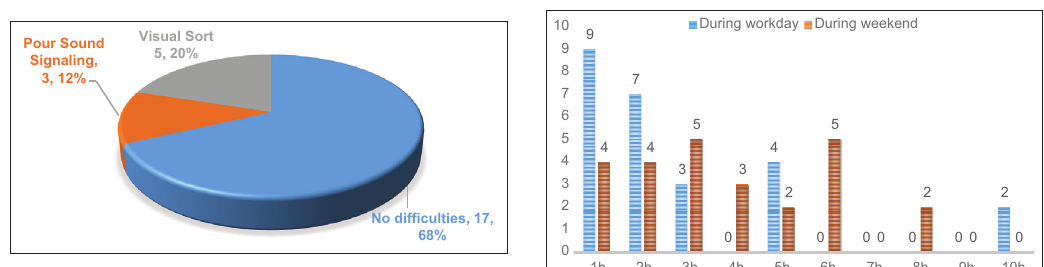
CHART 15. Most frequent difficulties at leisure, sports, and physical activities in free time. (Pour Sound Signaling - Visual Sort – No difficulties)